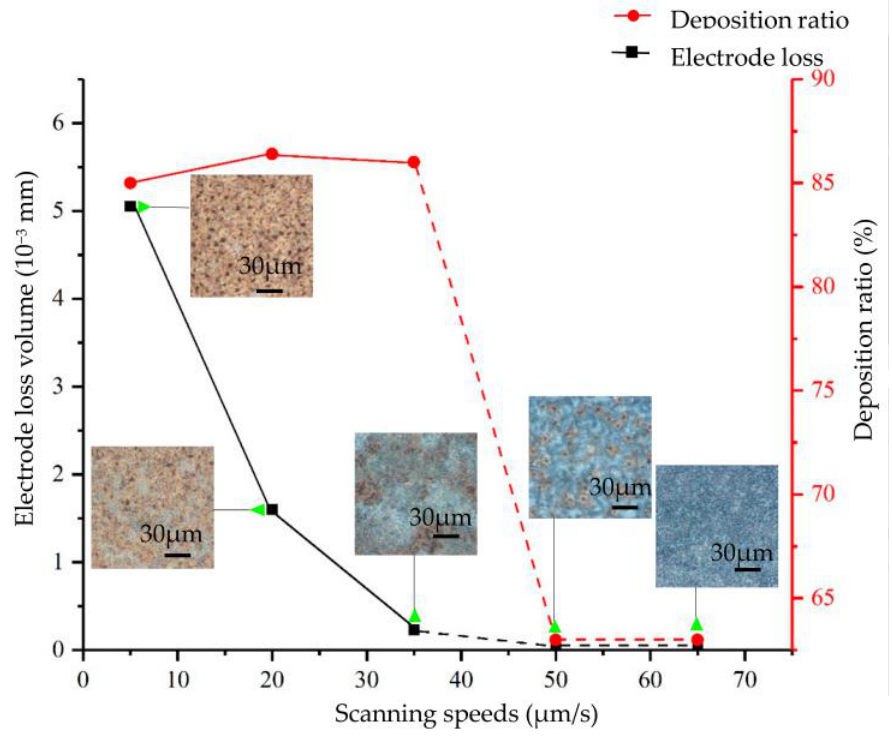
Figure 13. The e ff ect of scanning speeds on electrode loss volume and deposition